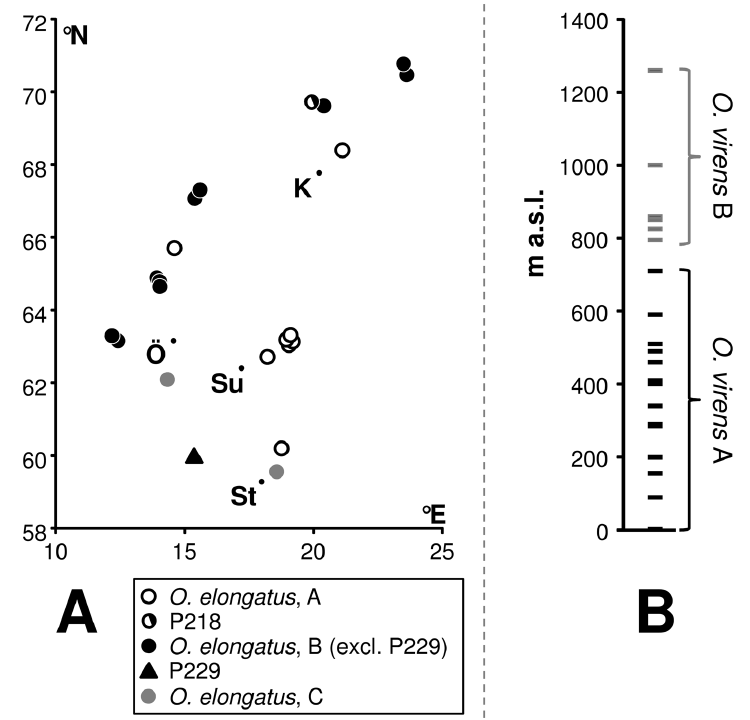
Fig. 5. A . Latitudinal and longitudinal distribution of Oncophorus elongatus samples belonging to different haplotypes or groups of haplotypes (cf., Fig. 1) based on ITS and plastid ( trn G, rps 4) data. Sample P218 is related to O. elongatus B according to ITS data and O. elongatus A according to plastid data (Fig. 1). The positions of the Swedish towns Kiruna (K), Stockholm (St), Sundsvall (Su), and Östersund (Ö) are indicated as references. B . Elevational distribution of the molecularly sampled Oncophorus virens A and B (P278-P280, P282, P289, P299, P300) in